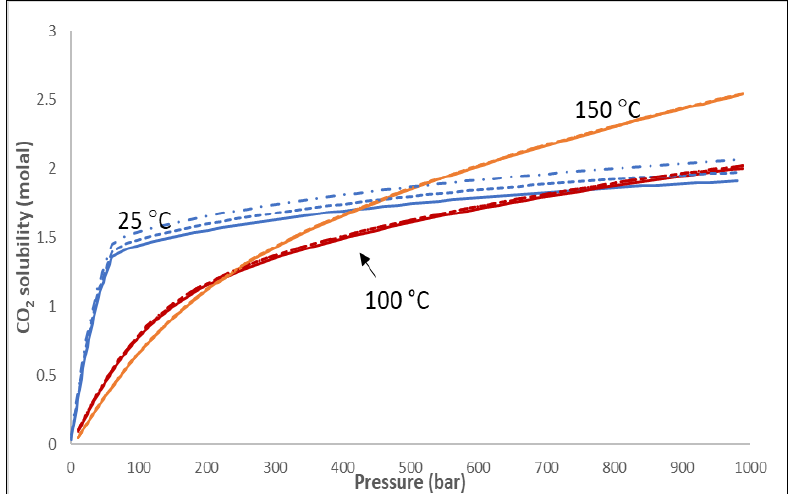
Figure 11. CO 2 solubility in pure water or carbonate mineral saturated solutions at different temperatures and pressures. Solid lines are CO 2 solubility in pure water. Dashed lines represent calcite saturated solutions. Dash-dot lines represent magnesite saturated solutions.